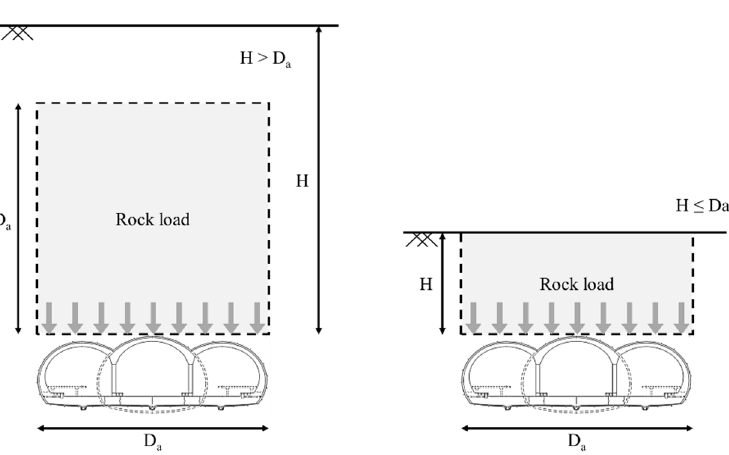
Figure 2. Empirical method to estimate rock load acting on the multi-arch tunnel.